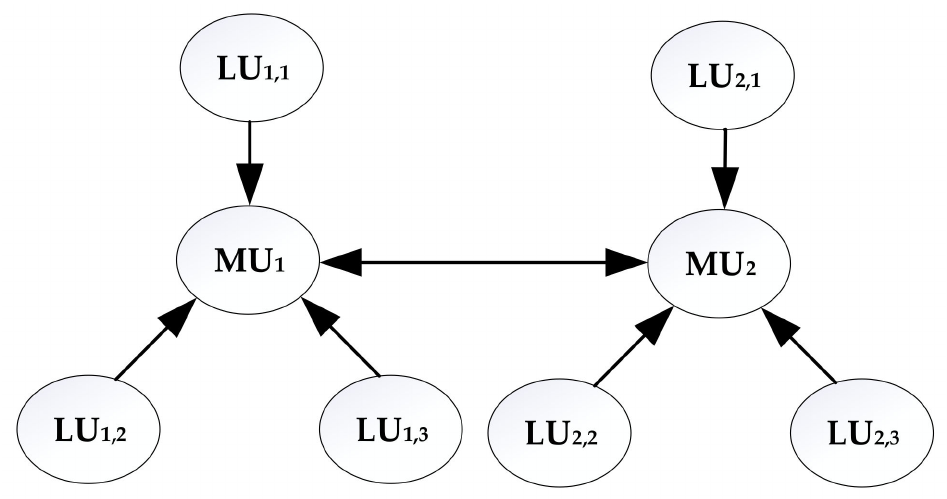
Figure 2. Improved multi-universe superstar structure. MU denotes the main universe and LU denotes the small